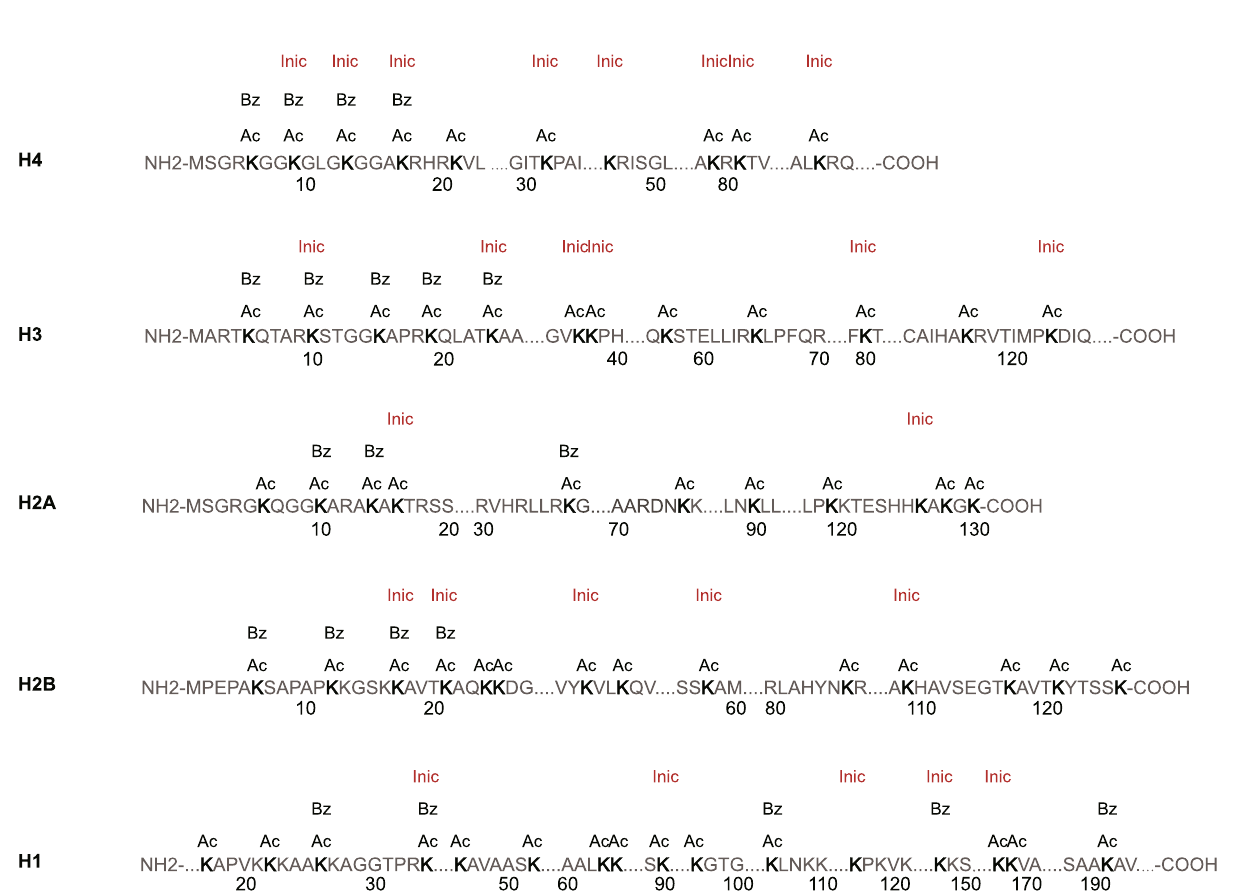
Fig. 3 Identi fi cation of K inic sites in histones of HepG2 cells. The detected K inic sites in HepG2 cells treated with 10 mM INH for 24 h using HPLC-MS/MS assay are shown in red. And histone K ac and K bz sites that were reported previously are shown for comparison. “ K ac ” indicates lysine acetylation, “ K bz ” indicates lysine benzoylation, “ K inic ” indicates lysine